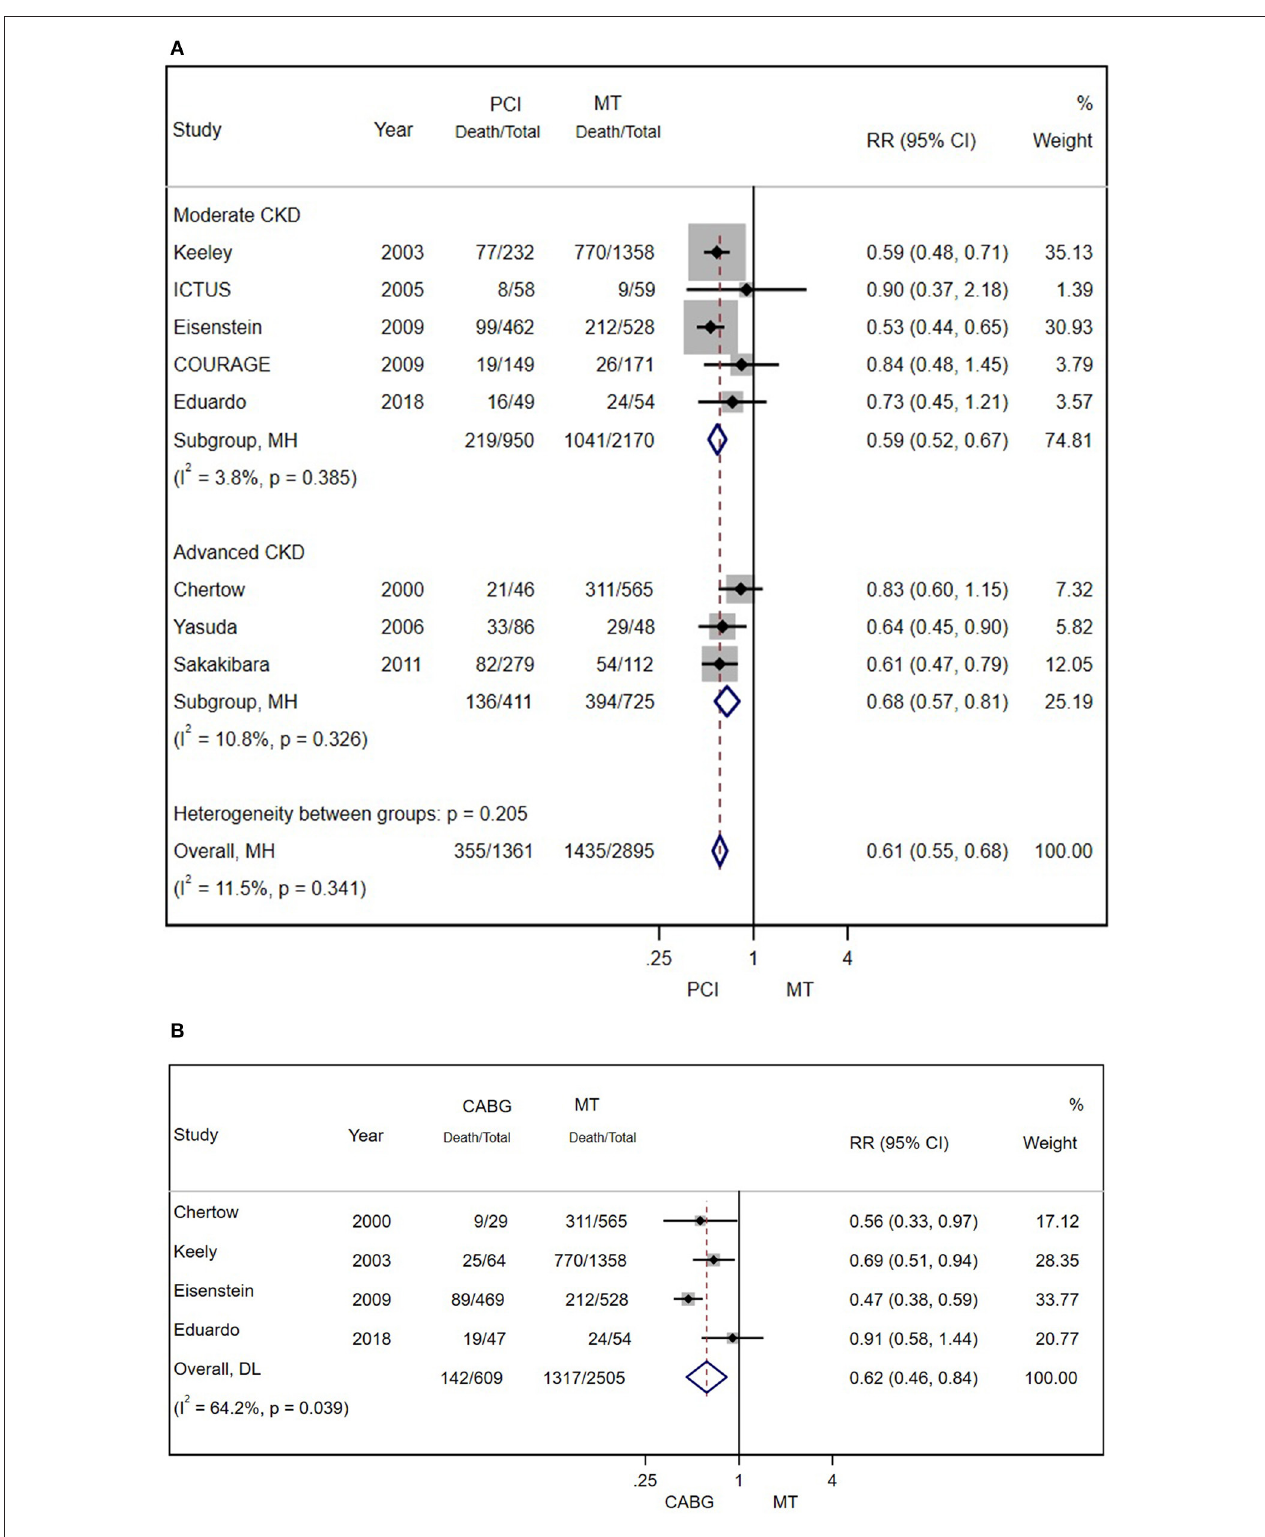
FIGURE 4 | (A) Pooled effect of percutaneous coronary intervention (PCI) and MT alone on the long-term mortality of patients with CAD and CKD. Compared with MT alone, PCI was more effective in reducing mortality. Weights and between-subgroup heterogeneity test are from Mantel-Haenszel model. (B) The pooled effect of CABG and MT alone on the long-term mortality of patients with CAD and CKD. Compared with MT alone, PCI was more effective in reducing mortality. Weights and between-subgroup heterogeneity test are from random-effects model.